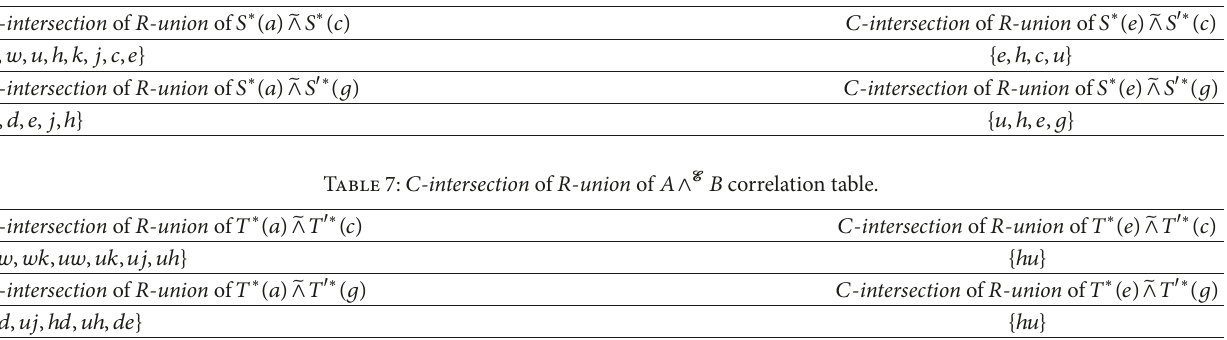
Table 6: 𝐶 - intersection of 𝑅 - union of 𝐴∧ 𝑋 𝐵 correlation table.